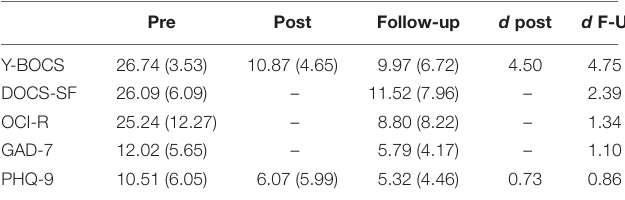
TABLE 2 | Means, standard deviations and effect sizes (Cohen’s d ) for symptoms of OCD, anxiety, and depression.